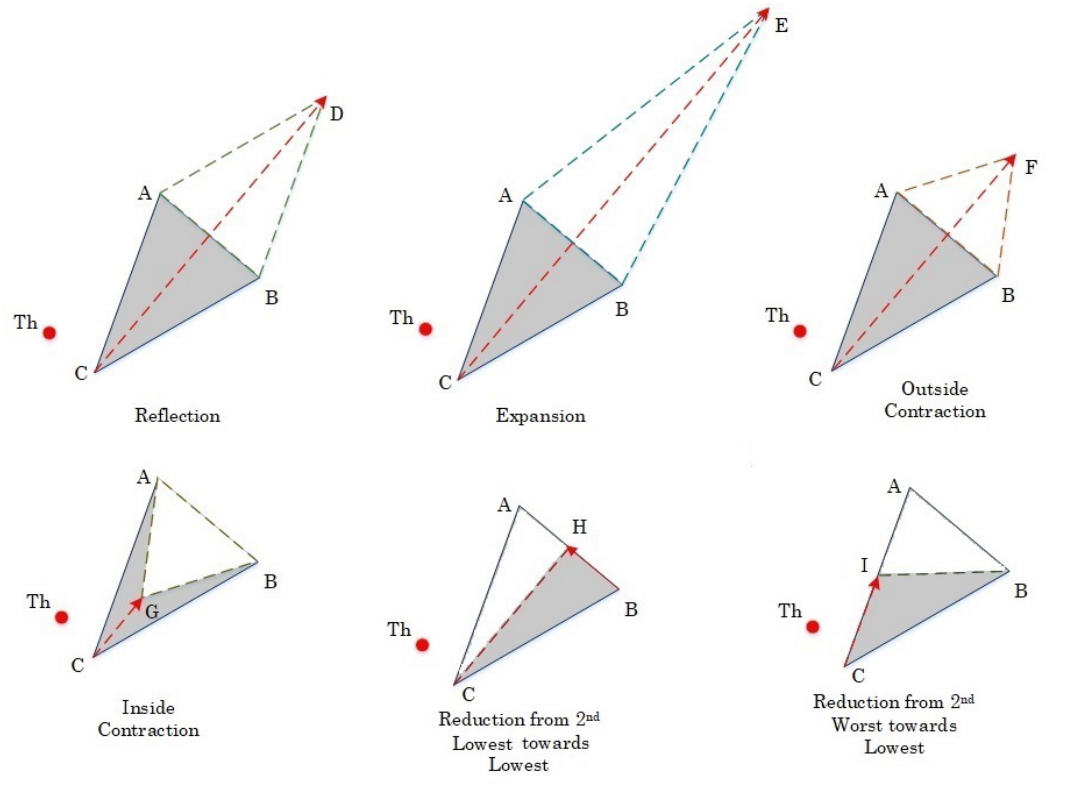
Figure 2. The basic operations of the HNM